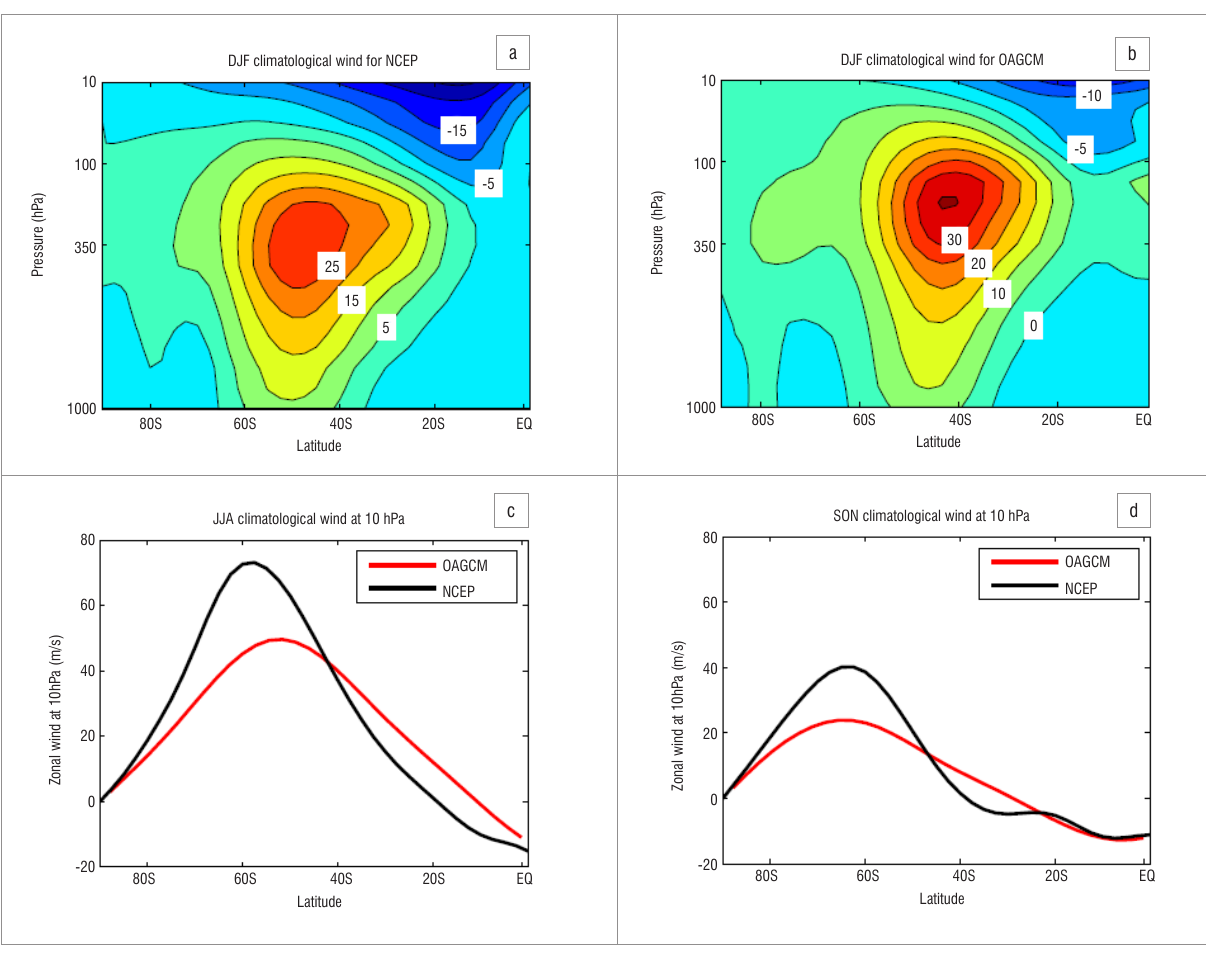
Figure 1: Zonal wind component averaged in the longitudinal direction for (a) NCEP and (b) OAGCM at all isobaric levels during December-January-February (DJF) and at 10 hPa during (c) June-July-August (JJA) and (d) September-October-November (SON). (a and b) Summer (DJF) tropospheric wind response to the strength of stratospheric polar vortex during (c) winter (JJA) and (d) spring (SON). Red contours in (c) and (d) represent OAGCM data and black contours represent NCEP data. Wind speed is measured in